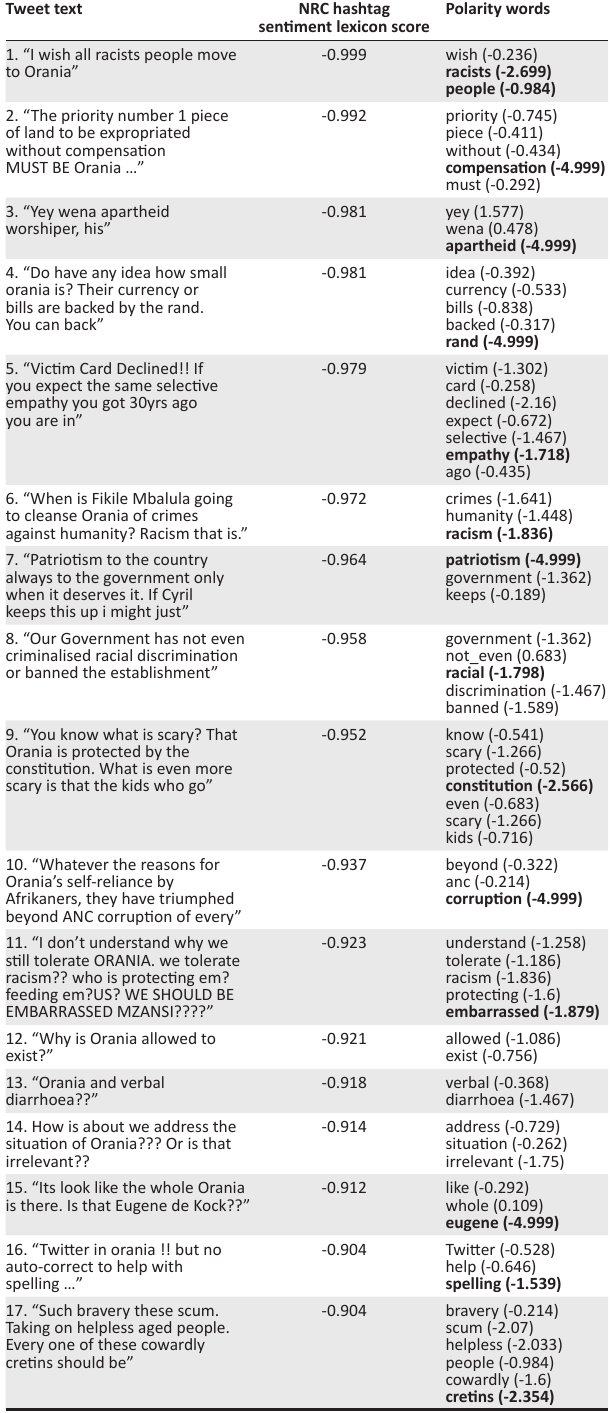
TABLE 8: The most negative